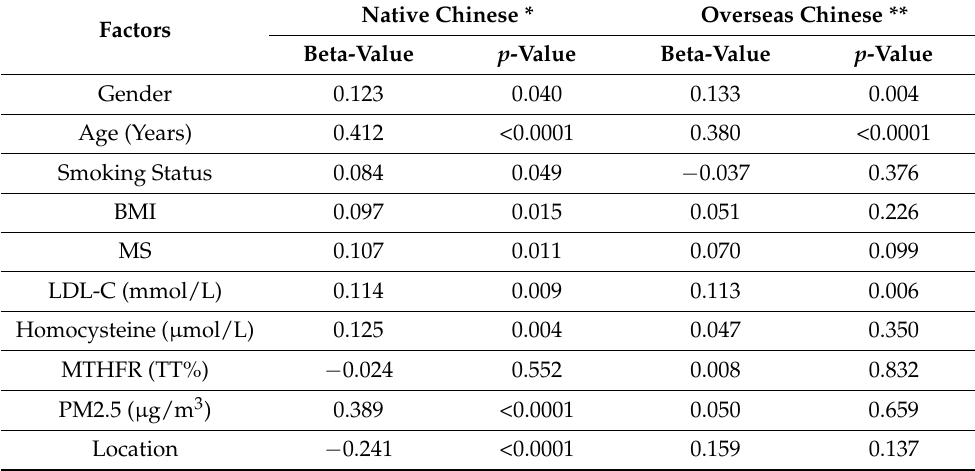
Table 7. Determinants of risk factors for carotid IMT in 1263